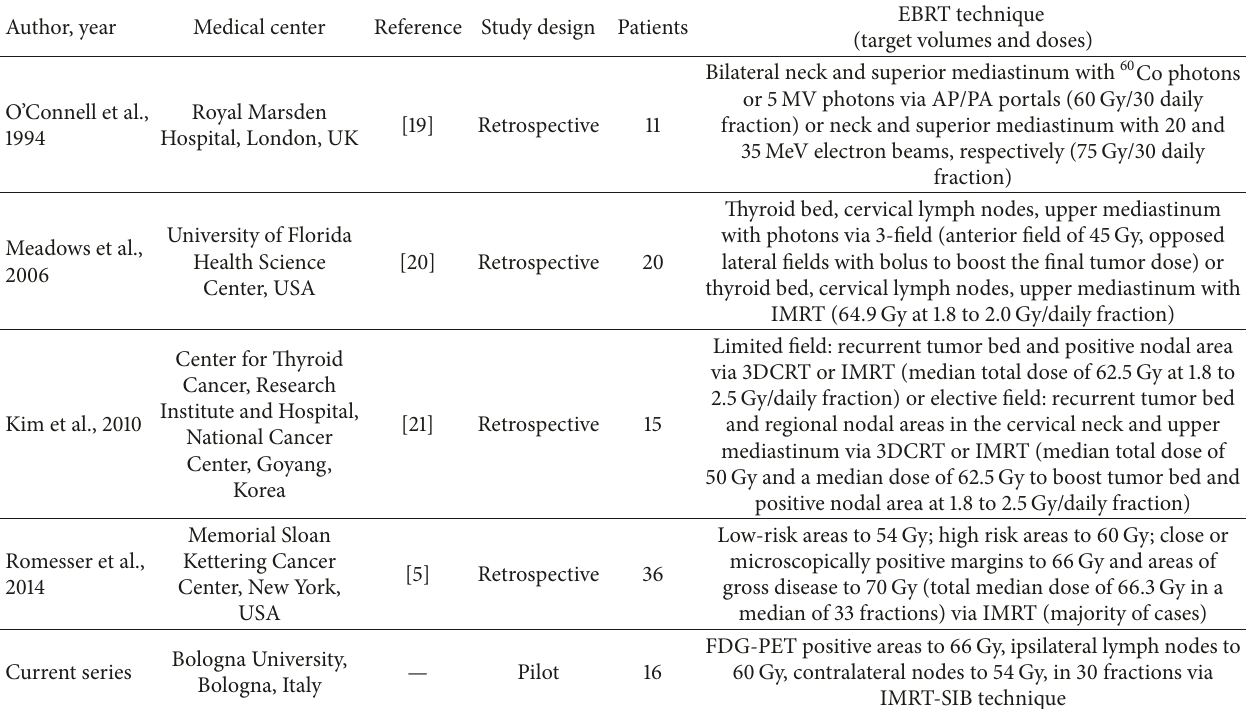
Table 5: Clinical studies: EBRT in locoregional differentiated thyroid cancer recurrence.